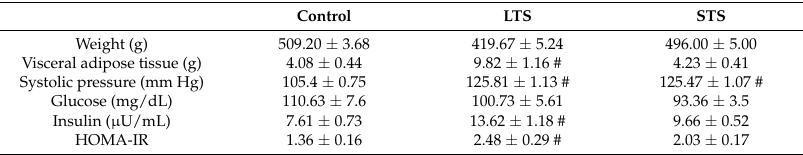
Table 1. The effects of long-term (LTS) and short-term (STS) administration of sucrose on body characteristics and biochemical parameters. Data represent mean ± standard error of the mean (SEM), # p < 0.01, after one-way analysis of variance (ANOVA), n = 10 determinations from 10 different rats from each